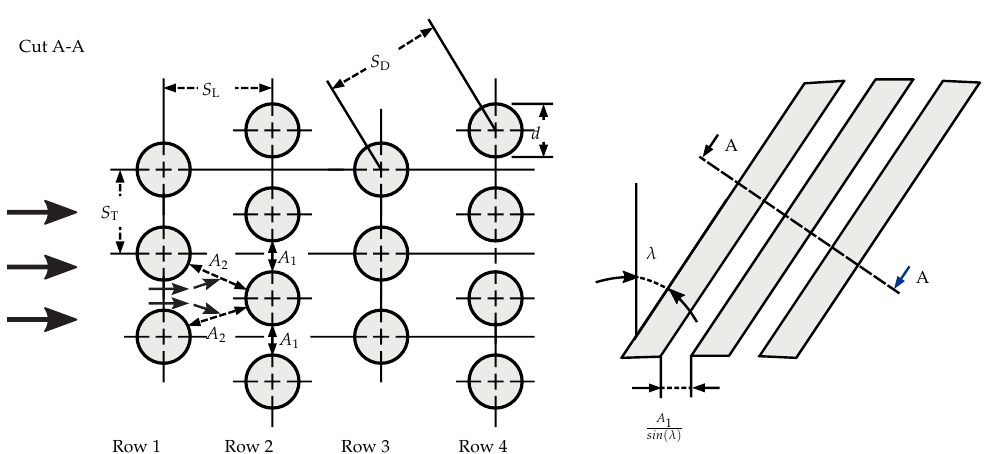
Figure A1. Arrangement of bristles in bristle